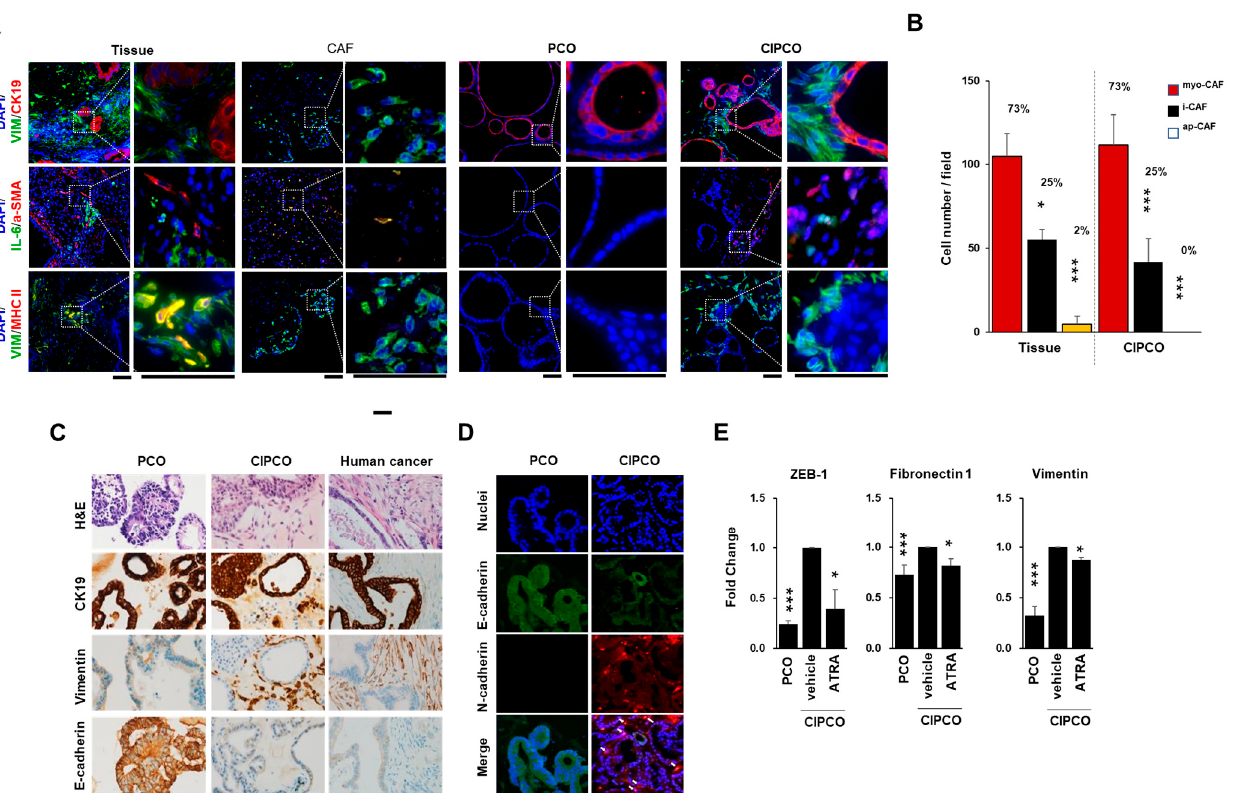
Figure 2. Characterization of CIPCOs. CIPCO analysis was performed on day 5. ( A ) Immunofluorescence images of human pancreatic cancer cells, CAFs, PCOs, and CIPCOs labeled with CK19, vimentin, IL-6, α -SMA, and MHC II. Bar = 100 µm. ( B ) Quantitative analysis of iCAFs and myoCAFs in PCOs, CAFs, CIPCOs, and human pancreatic cancer tissue. ( n = 5) * p < 0.05, *** p < 0.001. ( C ) Immunohistochemical images of PCO and CIPCO models labeled with E-cadherin, CK19, and vimentin. Bar = 100 µm. ( D ) Immunofluorescence images of PCO and CIPCO models labeled with E-cadherin and N-cadherin. Bar = 100 µm. ( E ) qRT-PCR analysis of cancer cells from CIPCOs after treatment with 100 µM of all-trans retinoic acid (ATRA). ( n = 8) * p < 0.05, *** p < 0.001.